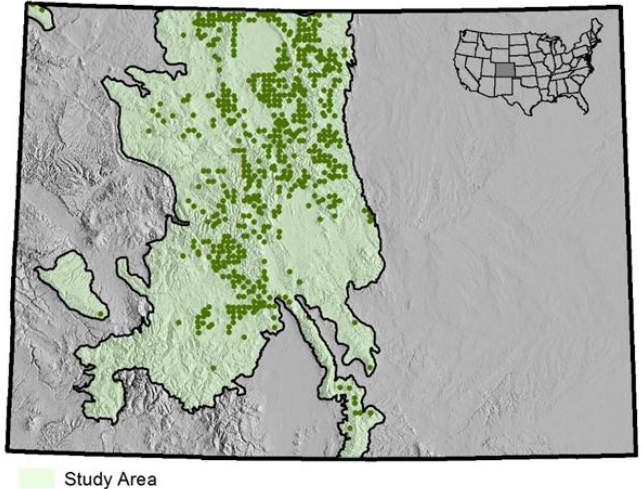
Figure 2. Approximate locations of FIA ground (field) plots in study area that are classified as forest with lodgepole pine trees. The figure does not identify locations for the remaining 75% of other FIA sample plots in the study area, which are distributed on an approximate 5 km by 5 km grid; however, all sampled plots in the study area, regardless of forest classification, are used in the sample survey